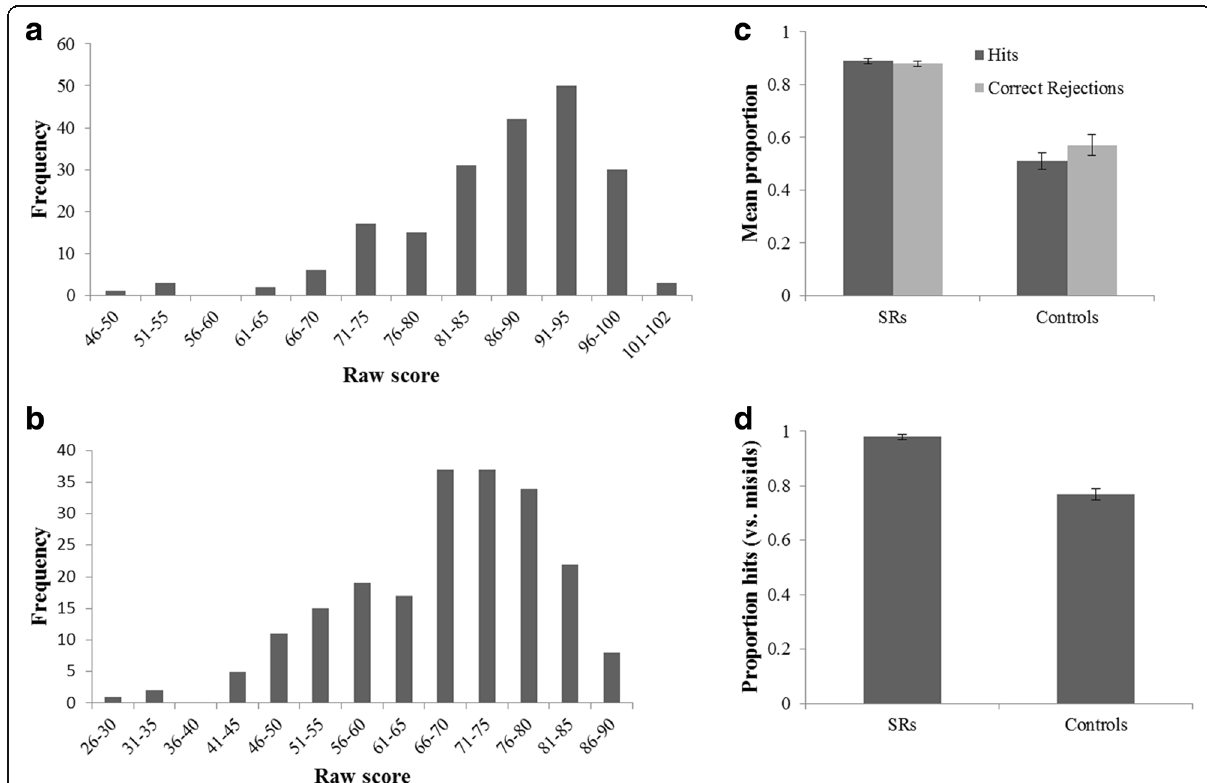
Fig. 4 Performance on the face memory tests. Distribution of experimental group ’ s performance on the ( a ) CFMT+ and ( b ) MMT, and the proportion and standard error of hits ( c ), correct rejections ( c ) and positive responses in target-present trials that were hits (vs misidentifications) ( d ) made by “ super recognisers ” (SRs) in comparison to controls on the